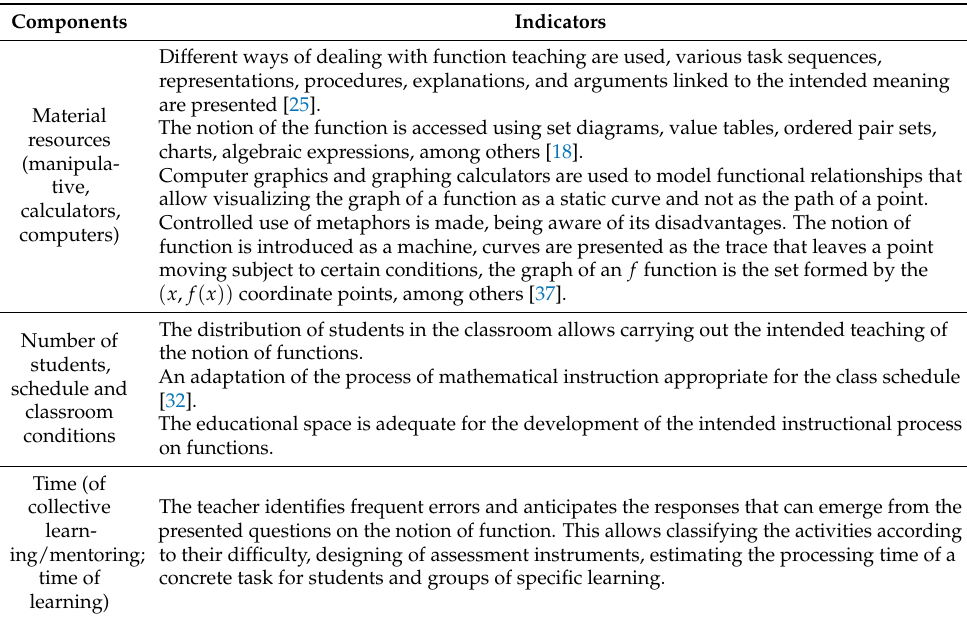
Table 5. Mediational suitability for teaching functions.